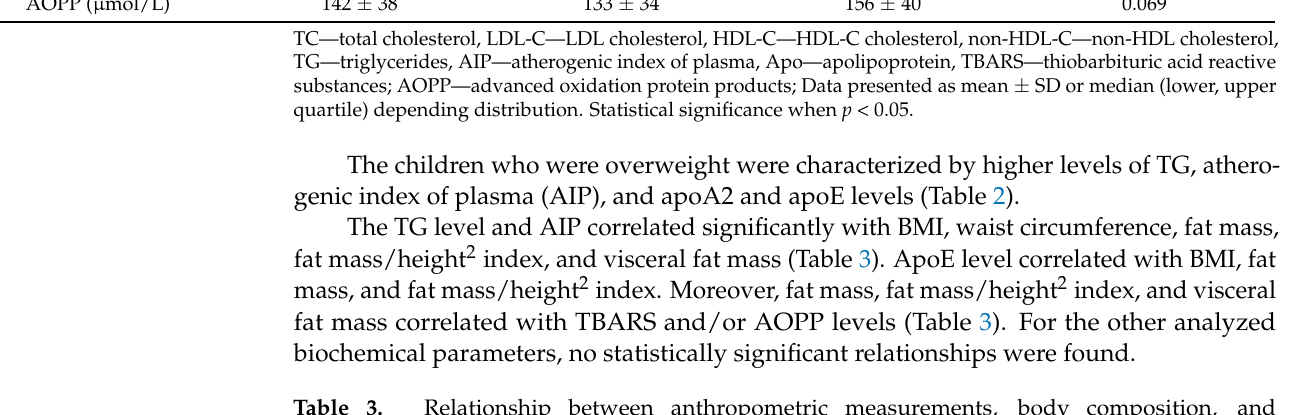
Relationship between anthropometric measurements, body composition, and biochemical